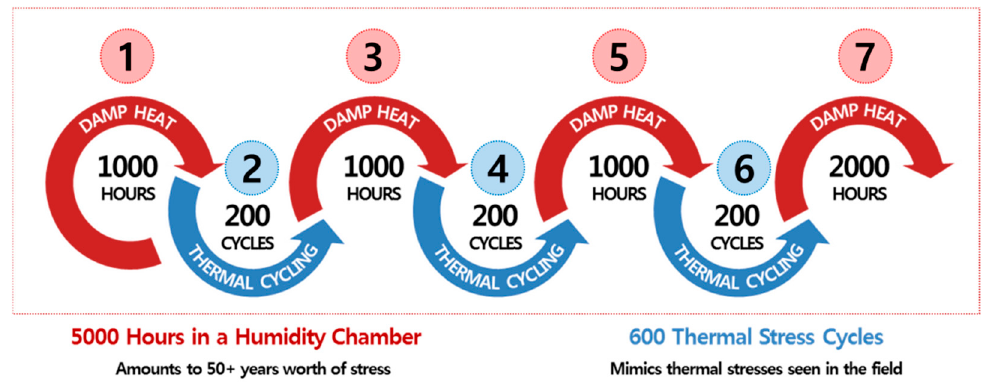
Figure 2. Schemes of DH5000 − TC600 combined acceleration test.